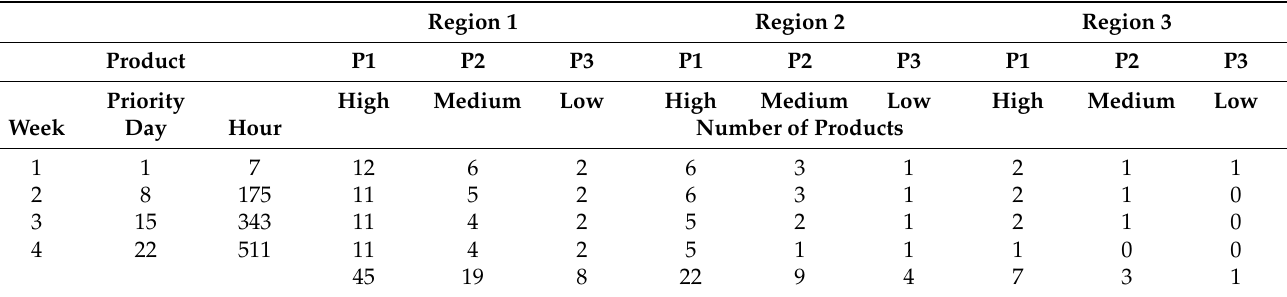
Table 11. Monthly order record for scenario